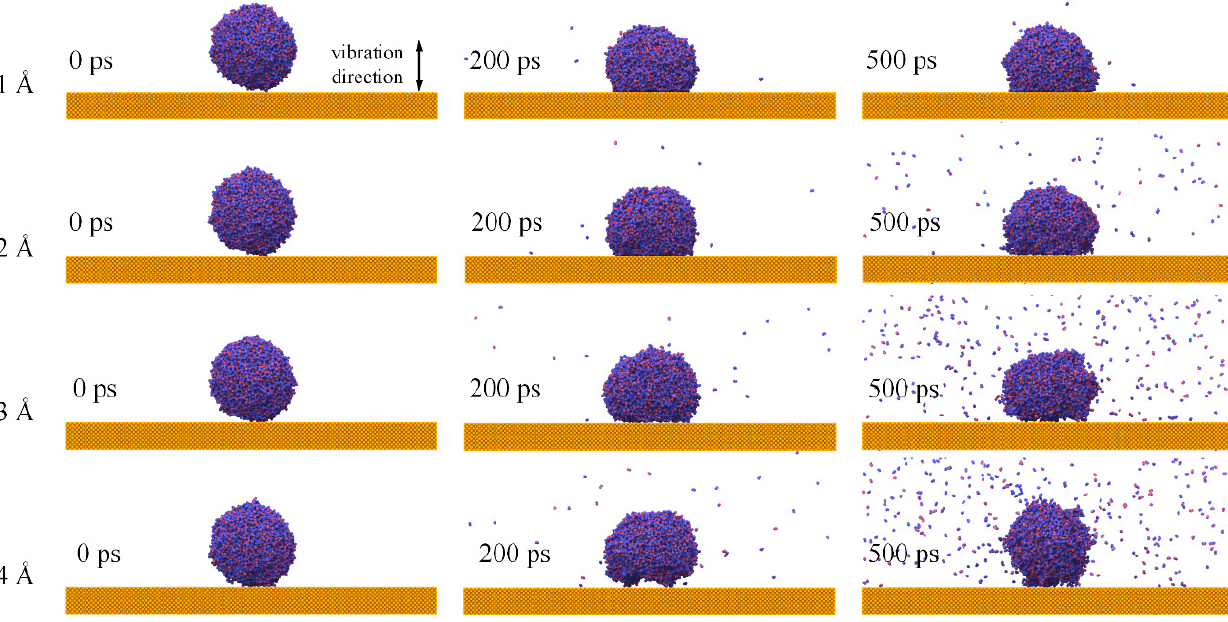
Figure 12. Morphological evolution of water nanodroplets impinging on vibration surfaces with various amplitudes.